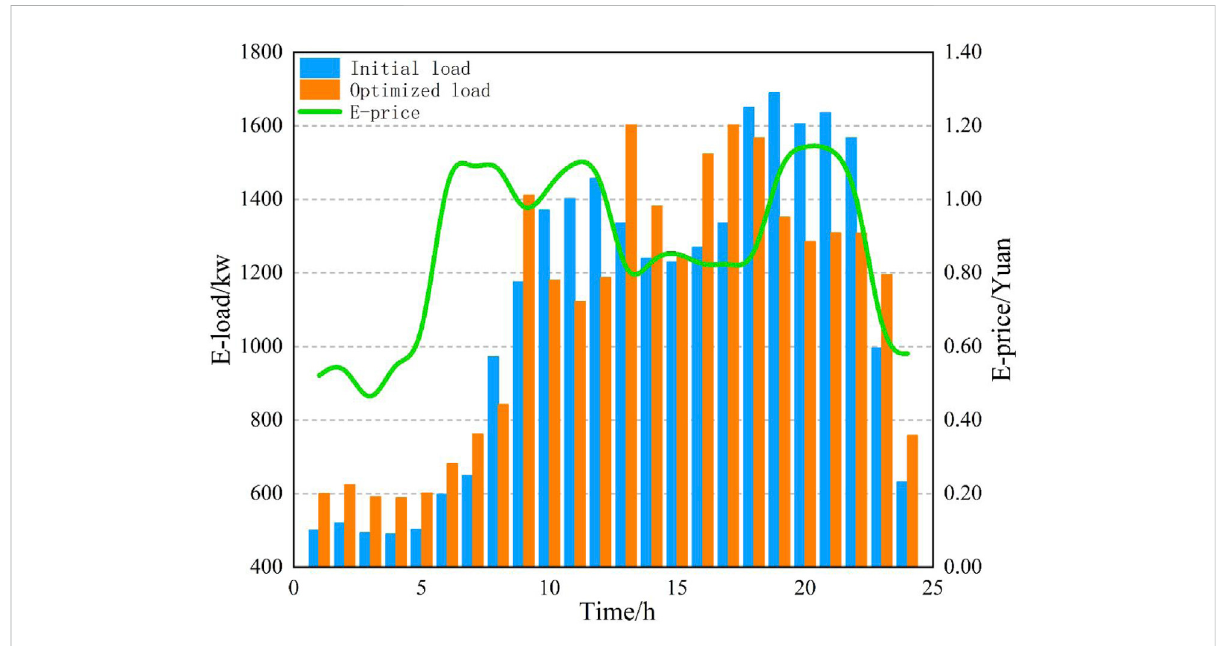
FIGURE 9 Optimizing after-load and electricity